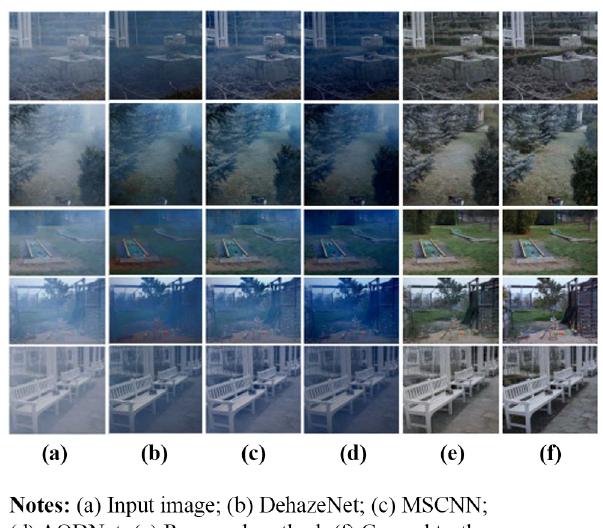
Figure 7. Dehazing results evaluated on NTIRE outdoor hazy images.